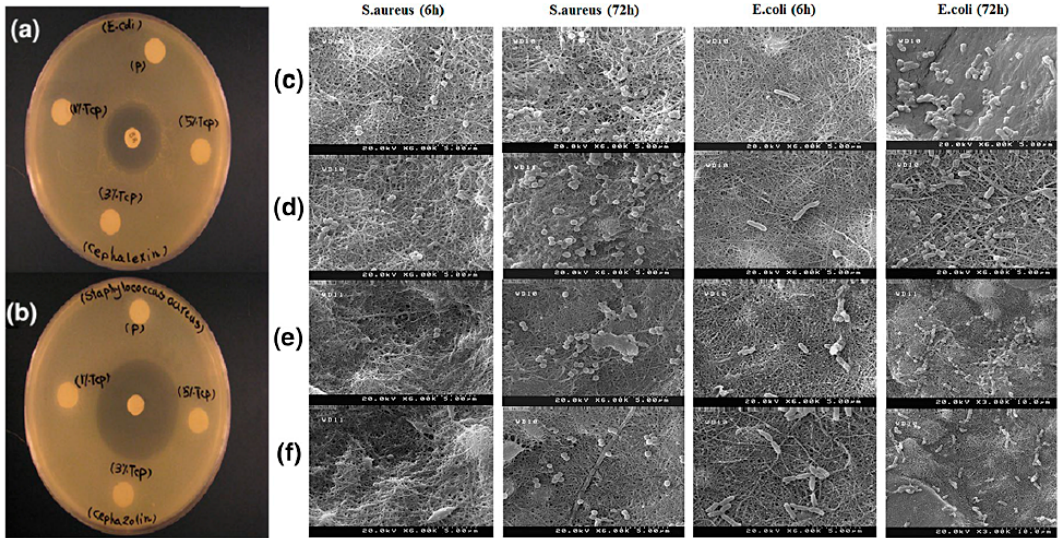
Figure 2. Antibacterial e ffi cacies of the chitosan-polycaprolactone (PCL) samples against S. aureus and E. coli evaluated by zone of inhibition assay ( a , b ). Scanning electron micrographs of S. aureus and E. coli adhered on the samples after 6 and 72 h ( c – f ). Reproduced from Ezati et al. 2018 [62], with